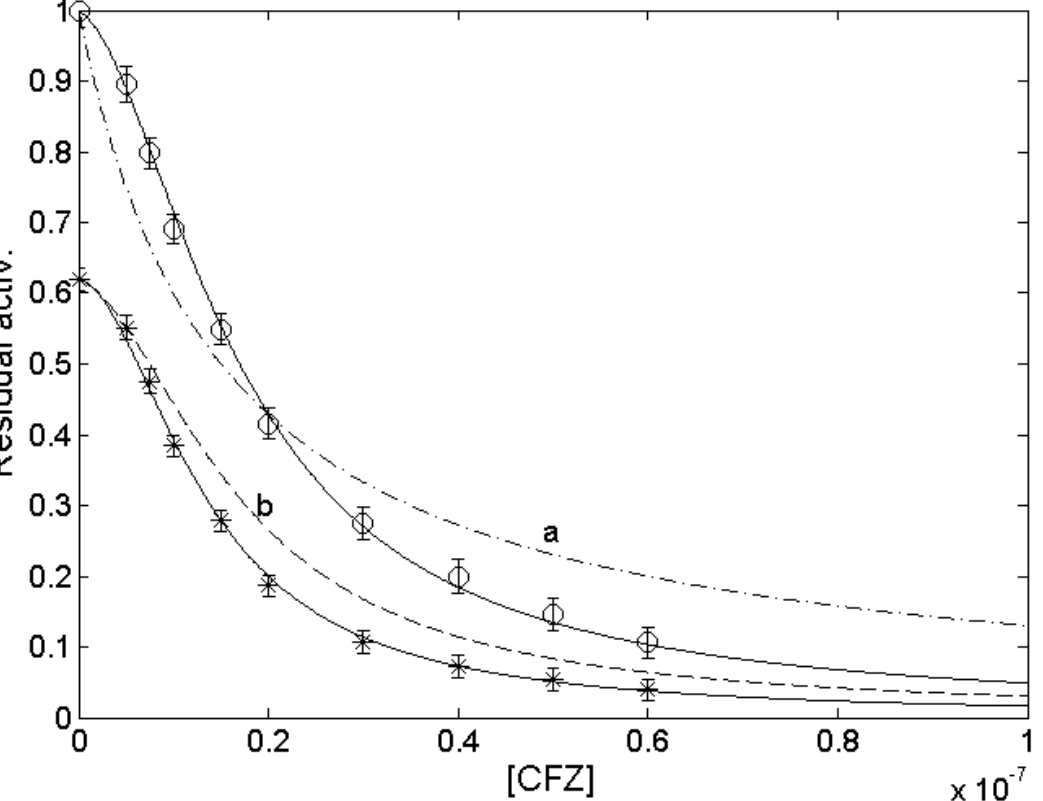
Figure 1. Residual chymotrypsin-like activity of 20S as a function of CFZ concentration in the absence (o) and in the presence of 20 nM IDE (*): continuous lines are non-linear-least squares fitting of data according to Equation (1); dashed line “a” is the non-linear least-squares fitting of data with δ = 1; dashed line “b” represents the expected inhibition curve of 20S assuming that IDE does not affect the inhibitory mechanism of CFZ. Table 1. Binding parameters of CFZ with 20S proteasome at pH 7.6 and 37 ◦